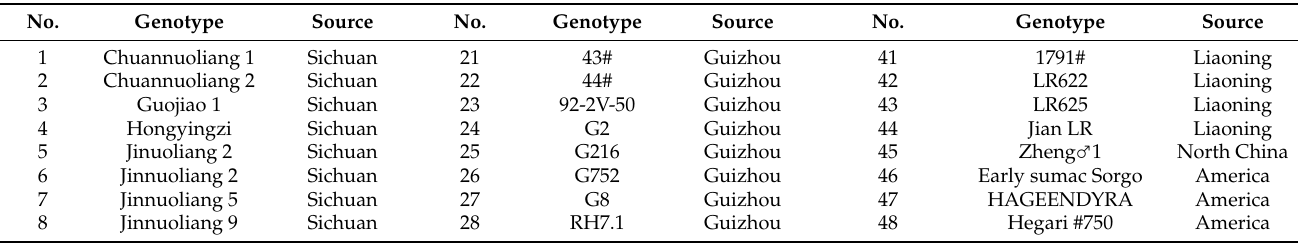
Table 1. Germplasm resources used in this